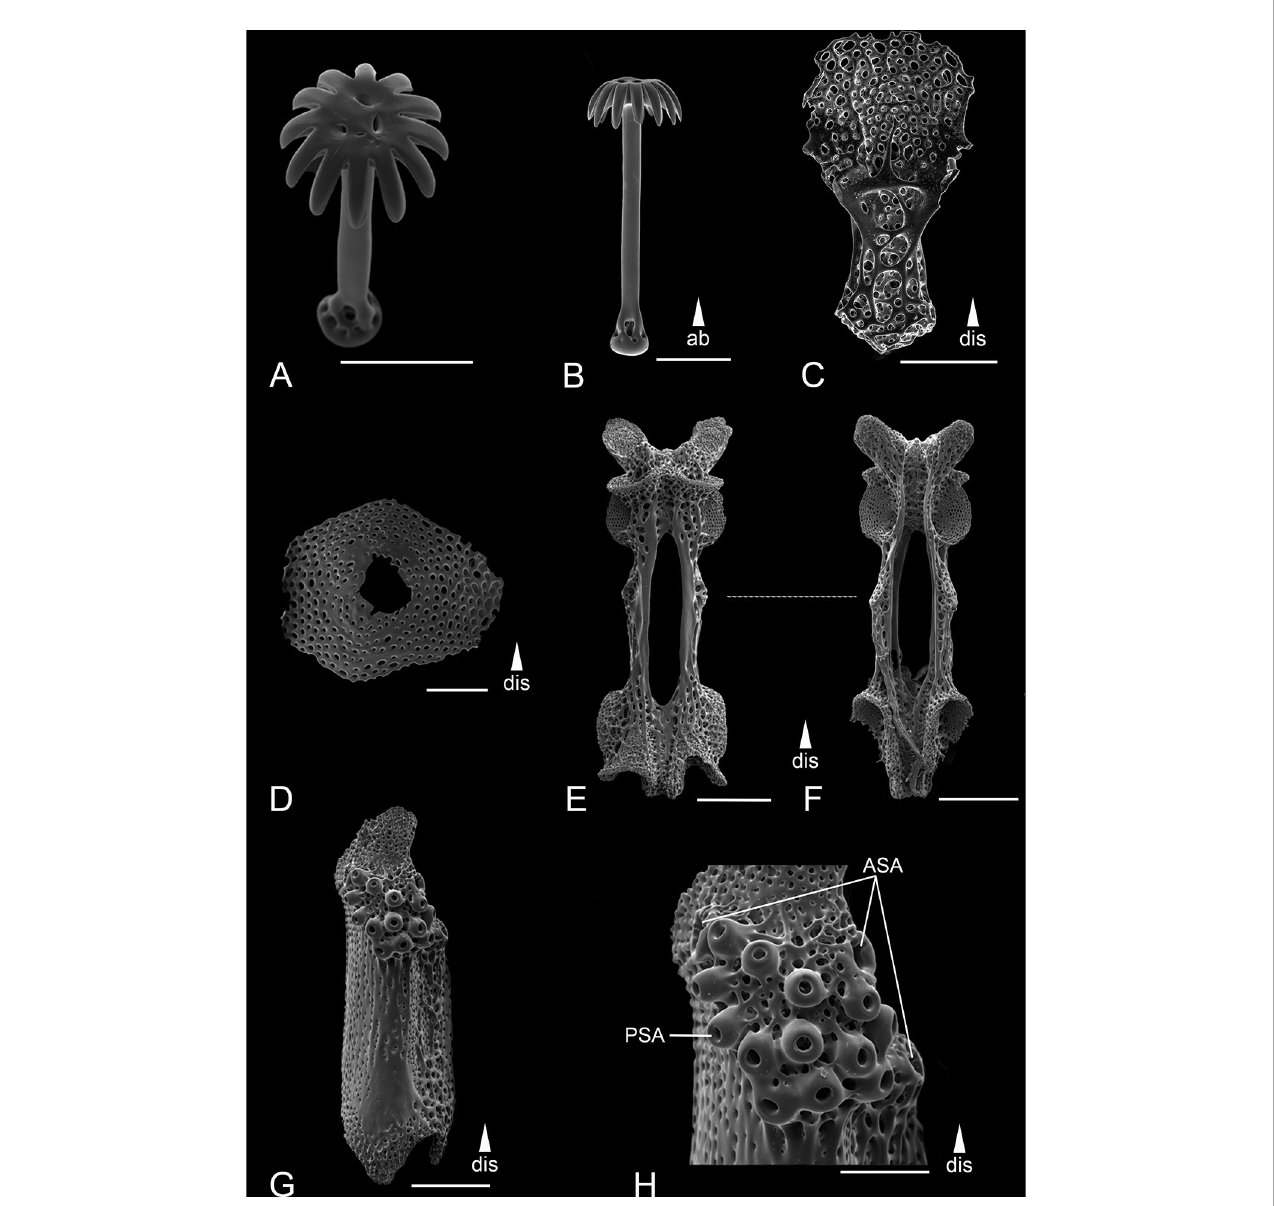
FIGURE 11 Scanning electron microscope images of the ossicles from Ophiotholia supplicans . (A) : Head of parasol-spine; (B) : Parasol-spine; (C) : Ventral arm plate; (D) : Dorsal arm plate; (E) : Arm vertebrae (ventral); (F) : Arm vertebrae (dorsal); (G) : Lateral arm plate; (H) : Close up lateral arm plate. Scales: 100 µm (A – D, H) ; 200 µm (E – G) . ab, abradial; ASA, arm spine articulation; dis, distal; PSA, parasol spine